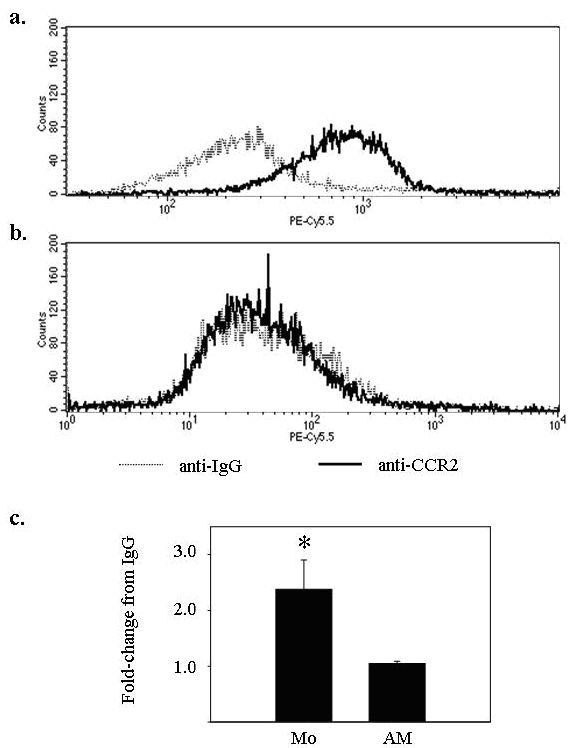
CCR2 surface protein is expressed at lower levels in alveolar macrophages compared to freshly isolated blood monocytes. (a) Monocytes (5 × 105 per condition) and (b) alveolar macrophages (5 × 105/condition) were isolated from the same donor and subjected to flow cytometric staining for CCR2 (solid line). (c) The average fold increase in CCR2 median fluorescence over isogenic IgG was 2.64 ± 0.48 for monocytes (*p < 0.05) and 1.12 ± 0.10 for alveolar macrophages (p > 0.05) for three independent experiments. IgG isotype controls are represented by dashed lines.